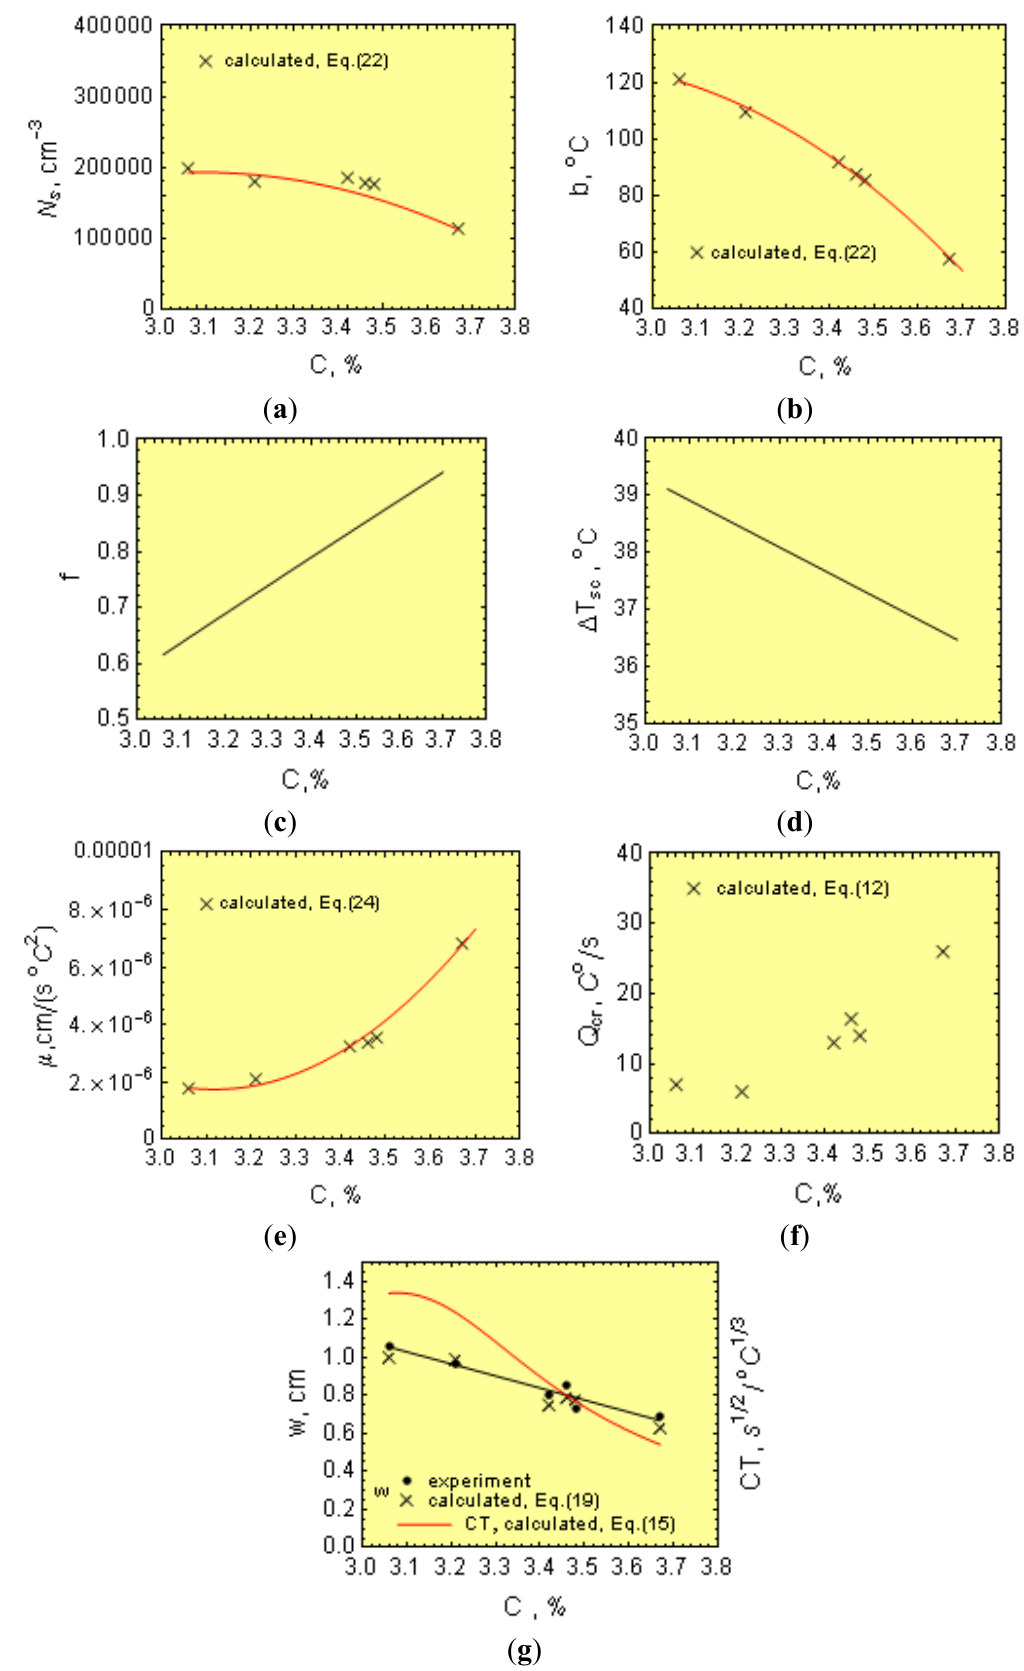
Figure 11. Effect of carbon on ( a ) N s , ( b ) b , ( c ) f , ( d )  T sc , ( e ) μ, ( f ) Q cr and ( g ) the chilling tendency (CT) index and